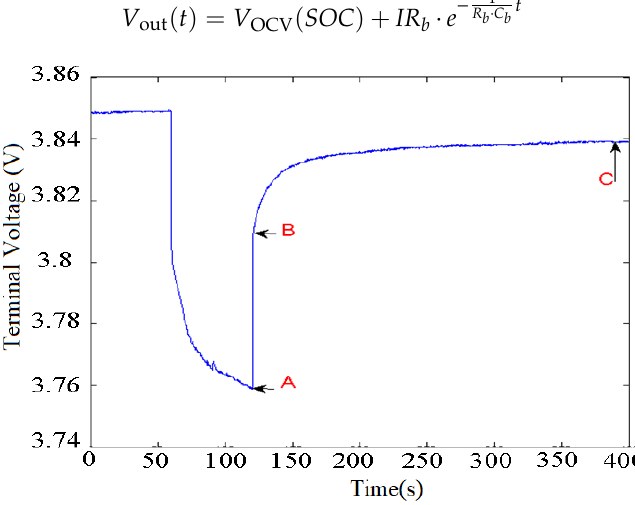
Figure 4. Typical discharge test curve of lithium battery.